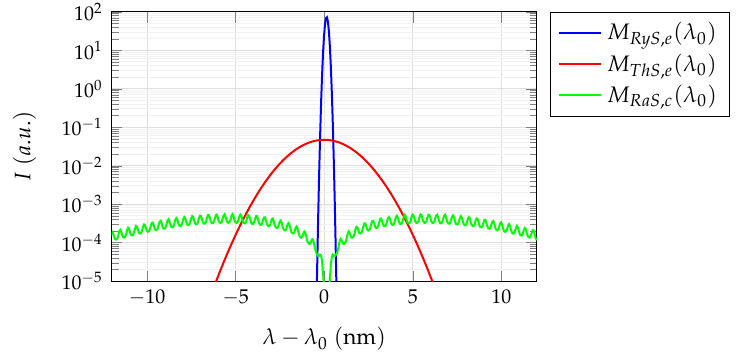
Figure 2. Comparison of intensities of the Rayleigh M RyS , e ( λ 0 ) and Thomson M ThS , e ( λ 0 ) signals measured for a pulsed, low-current nitrogen discharge and the calculated Raman M RaS , c ( λ 0 ) spectra. The heavy particle temperature needed for the calculation of M RaS , c ( λ 0 ) is determined from the experimentally measured M RyS , e ( λ 0 ) and M ThS , e ( λ 0 ) signals and amounts to T h = 3500 K. From the experimentally measured M RyS , e ( λ 0 ) and M ThS , e ( λ 0 ) signals, a heavy par- ticle temperature of 3500 K was determined for a pulsed, low-current nitrogen discharge operated at atmospheric pressure (described in Section 3.1). The M RaS ( λ ∗ ) signal was then calculated for this temperature and compared with the experimentally measured